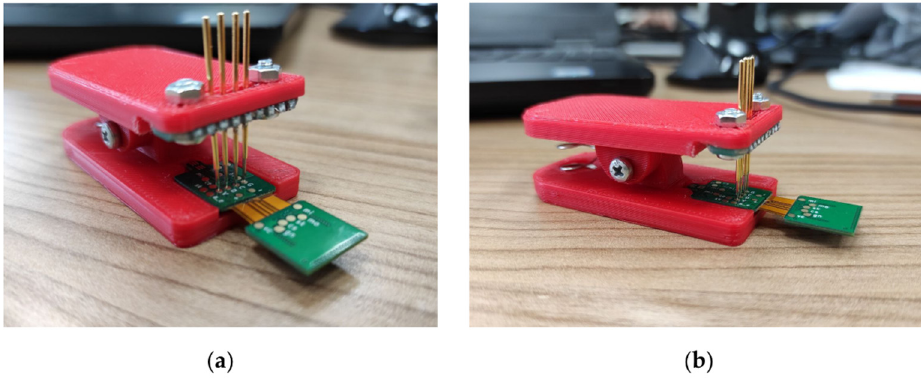
Figure 3. Clip adapter with spring-loaded contacts: ( a ) front view, ( b ) side view.